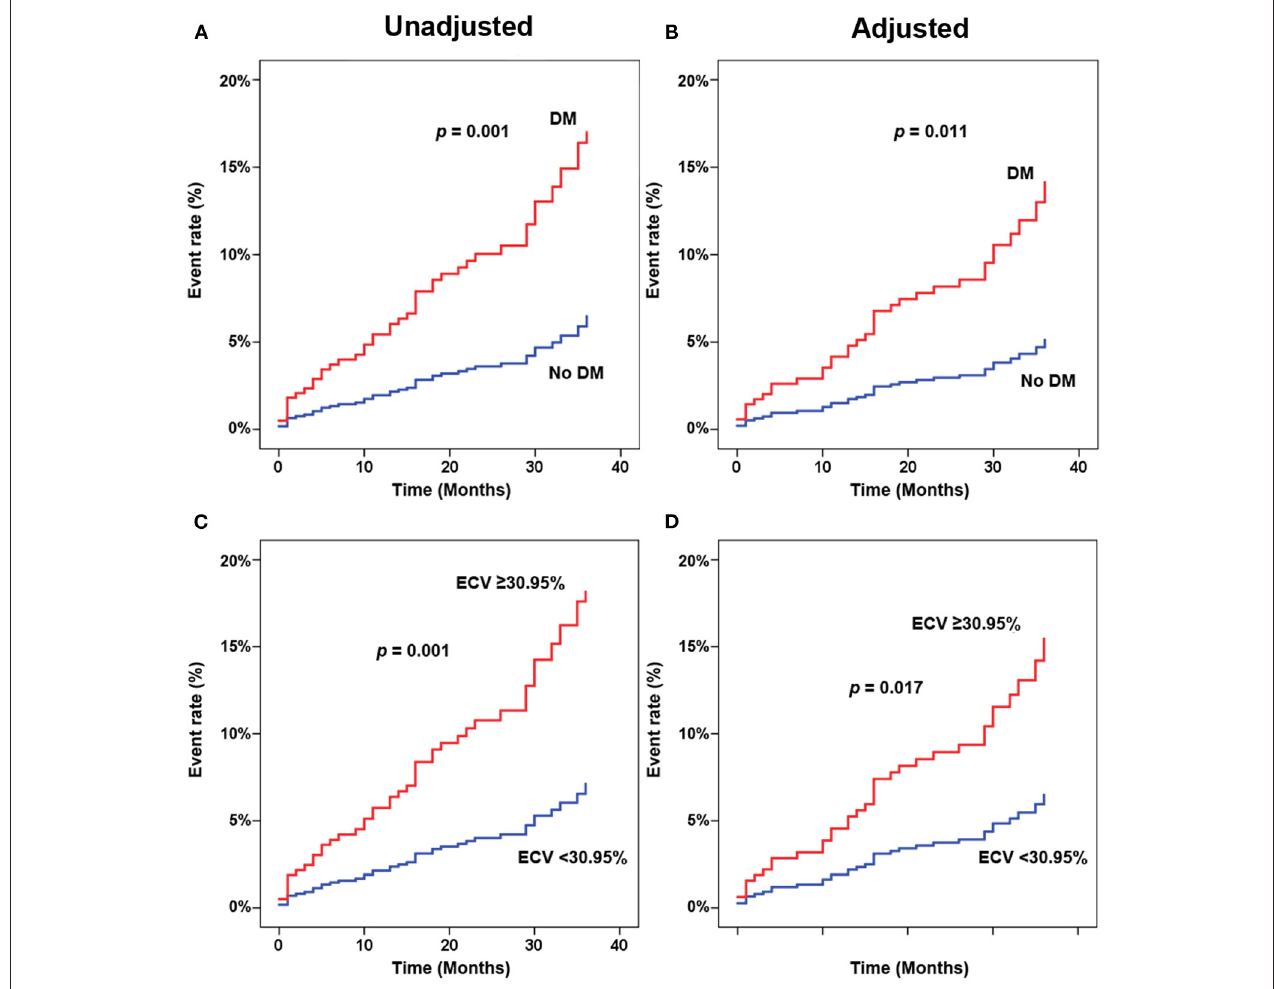
FIGURE 3 | Adjusted (A,C) and unadjusted (B,D) hazard graphs of the cumulative event rate compared between patients with and without type 2 diabetes (T2D) (A,B) , and between patients with extracellular volume fraction (ECV) above and below the cut-off value.